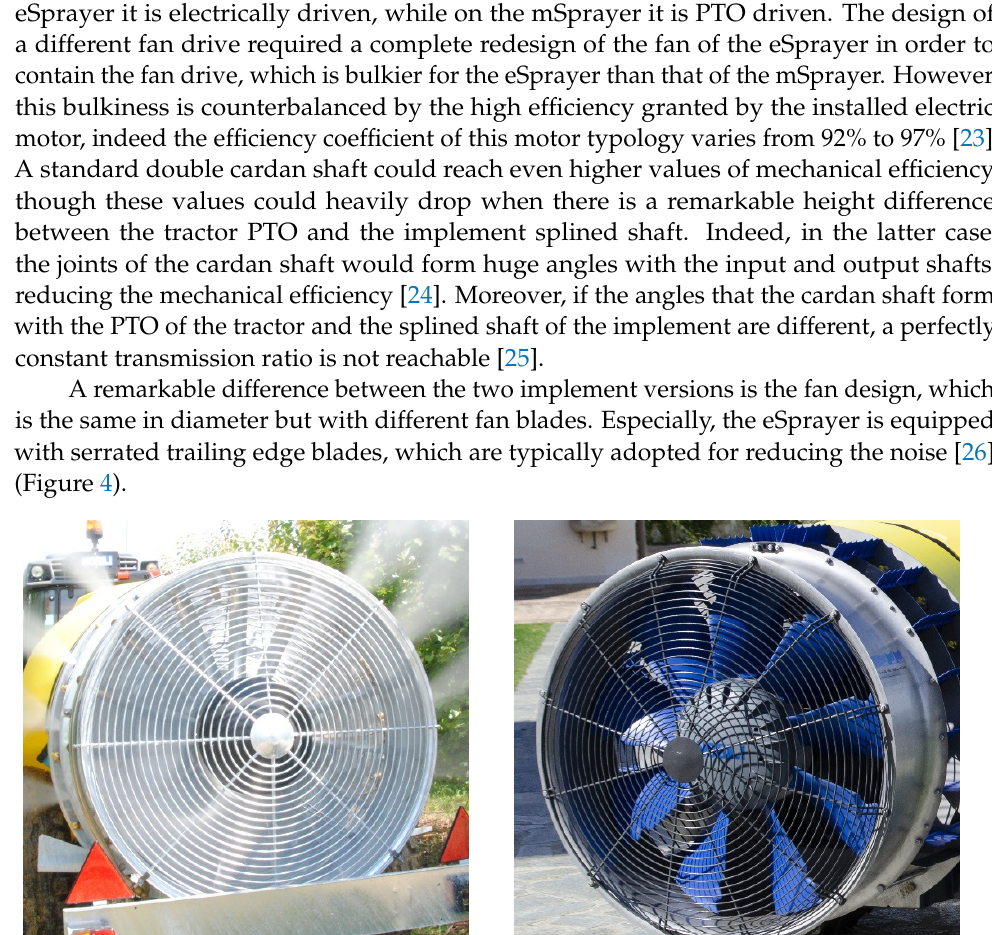
Figure 5. mMulcher ( a ) and eMulcher ( b ) developed by Nobili S.p.a. (Molinella (BO), Italy) used for the tests.